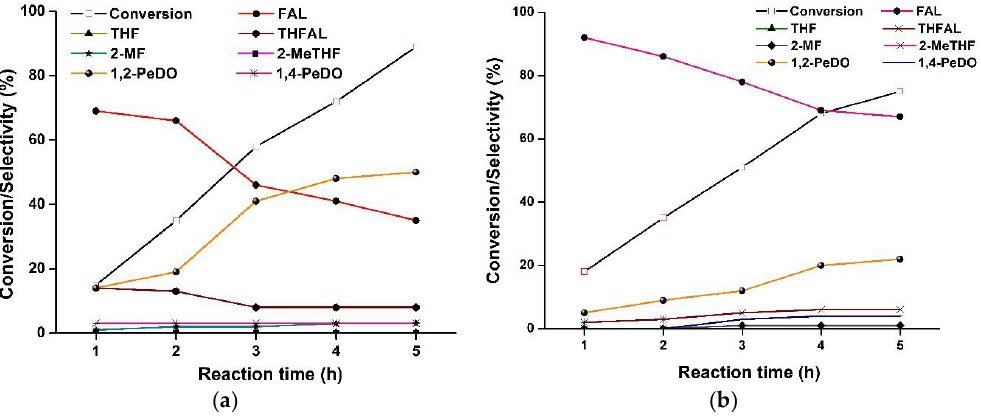
Figure 2. Conversion and selectivity vs time profiles over 2Pd2AuTi SBA ( a ) and 2Pd2AuSBA ( b ) catalysts. Reaction conditions: furfural 2.5 g; catalyst 0.25 g; temp.160 °C, H 2 500 psi; 1000 rpm; reaction time 5 h.